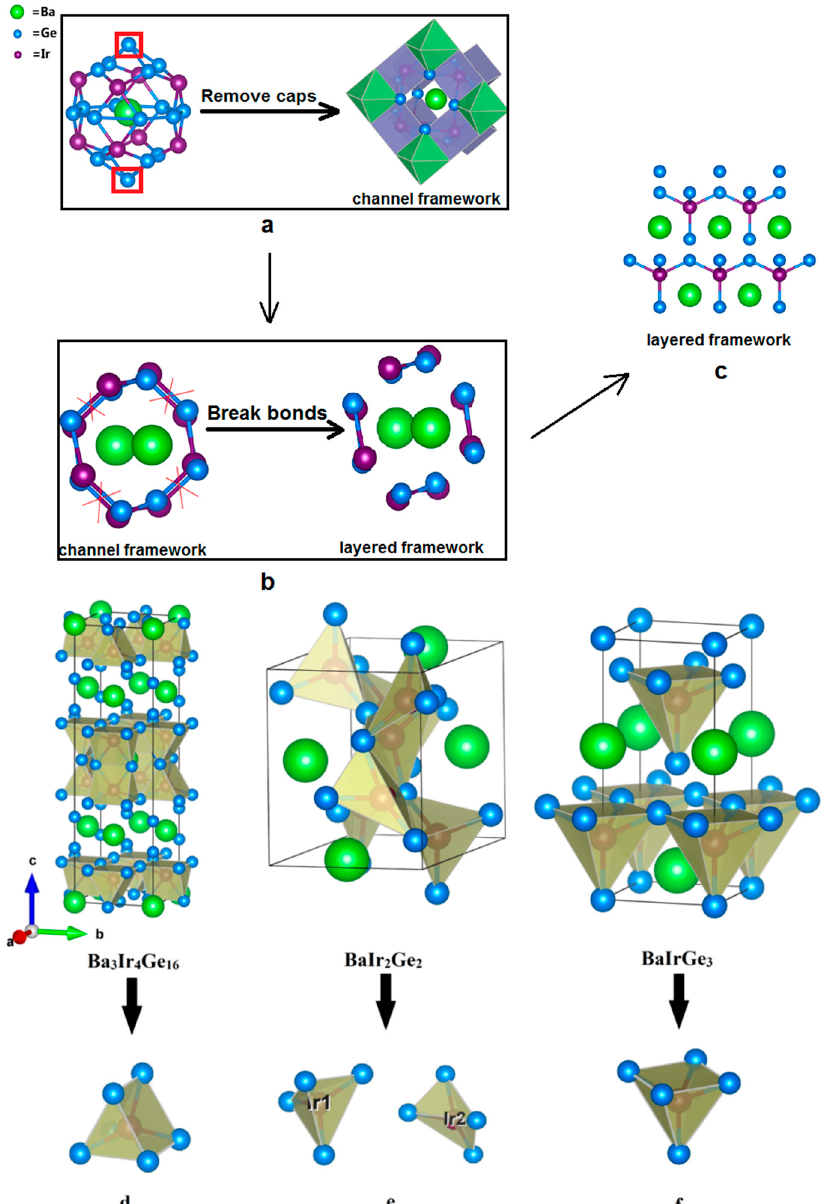
Figure 3. Structural comparison of 122-type phases. ( a ) Clathrate structure of Ba 3 Ir 4 Ge 16 ; ( b ) Channel framework of BaIr 2 Ge 2 ; ( c ) Layered structure of BaIrGe 3 ; ( d ) The symmetrical pentahedron in Ba 3 Ir 4 Ge 16 ; ( e ) The irregular, non-symmetrical tetrahedron in BaIr 2 Ge 2 ; ( f ) The square pyramid in BaIrGe 3 .